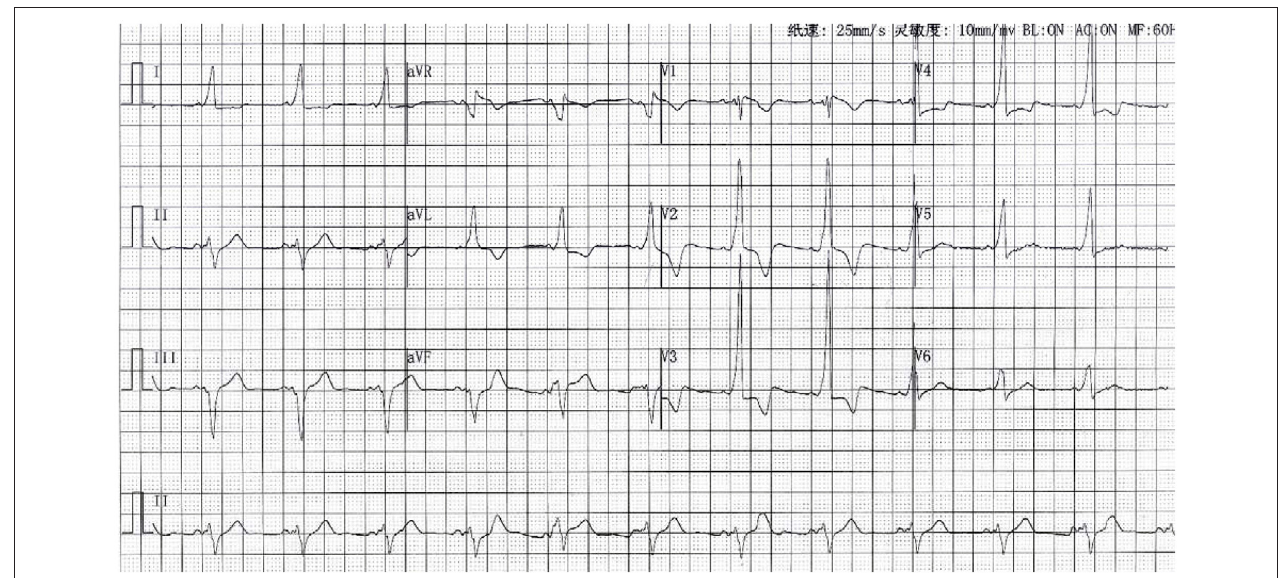
FIGURE 4 | The 12-lead ECG after antibacterial